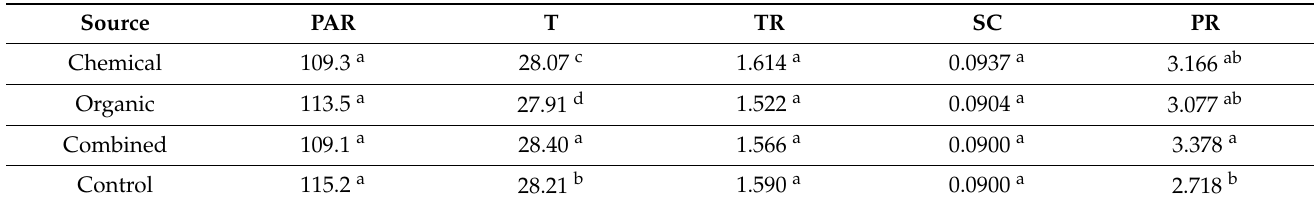
Table 9. Photosynthetically active radiation (PAR, µ mol m − 2 s − 1 ), temperature (T, ◦ C), transpiration